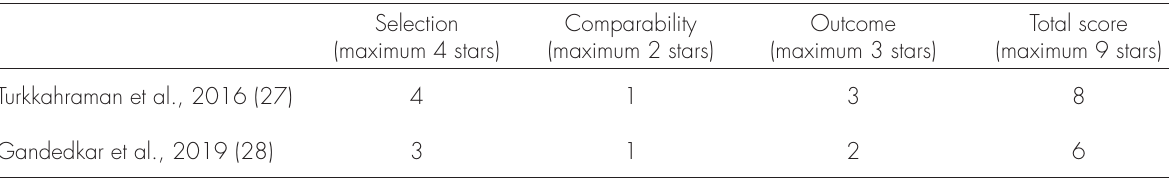
Table IV. Risk of bias assessment for CCTs following Newcastle-Ottawa